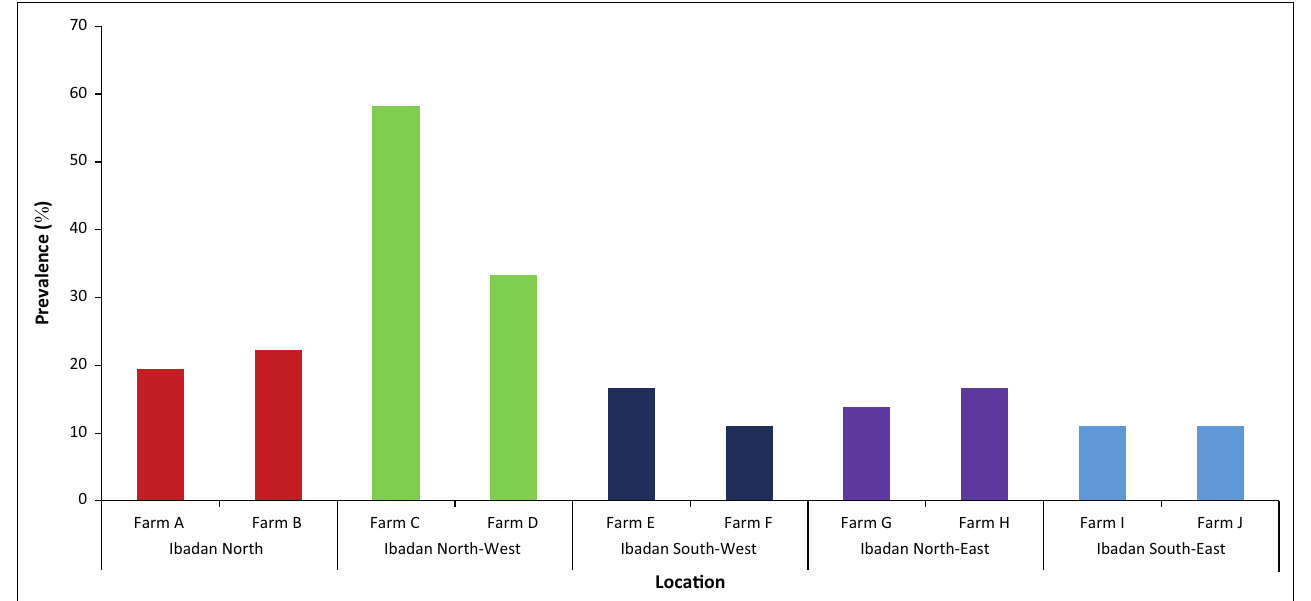
FIGURE 1: Occurrence of Salmonella species in chickens from poultry farms in Ibadan metropolis, Nigeria, April 2018 – November 2018.